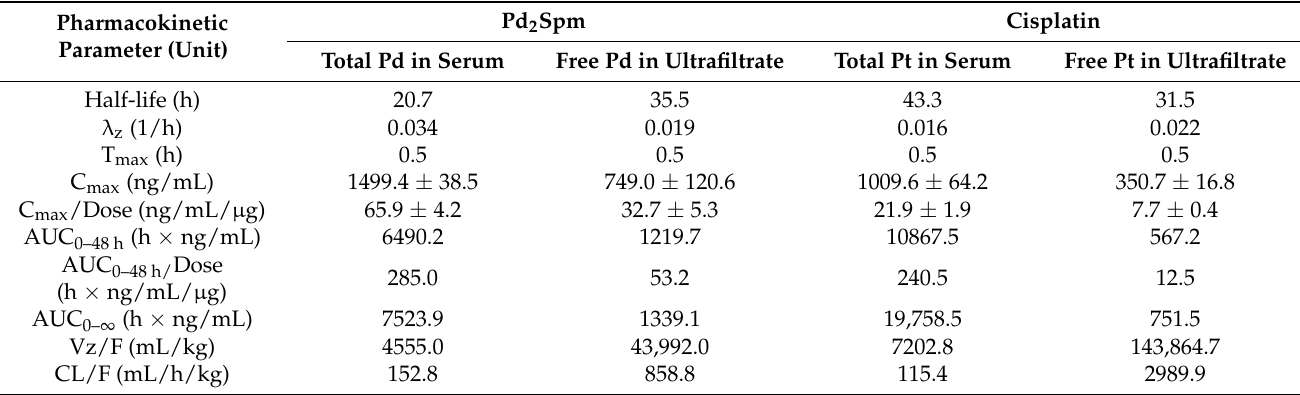
Table 1. Pharmacokinetic parameters of total Pd and Pt in serum and serum ultrafiltrate following intraperitoneal bolus